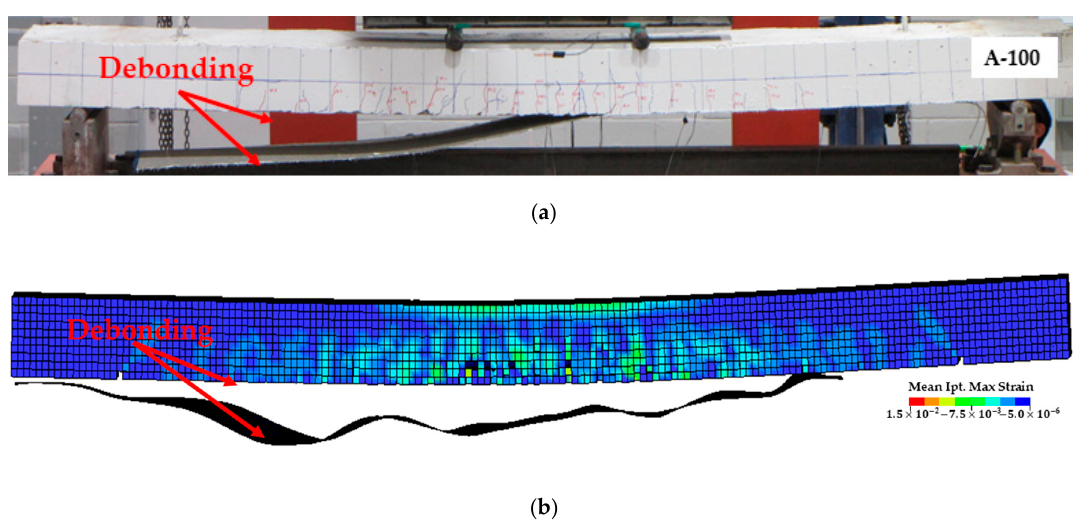
Figure 5. De-bonding failure mode (A-100). ( a ) Experiment. ( b ) Analysis.